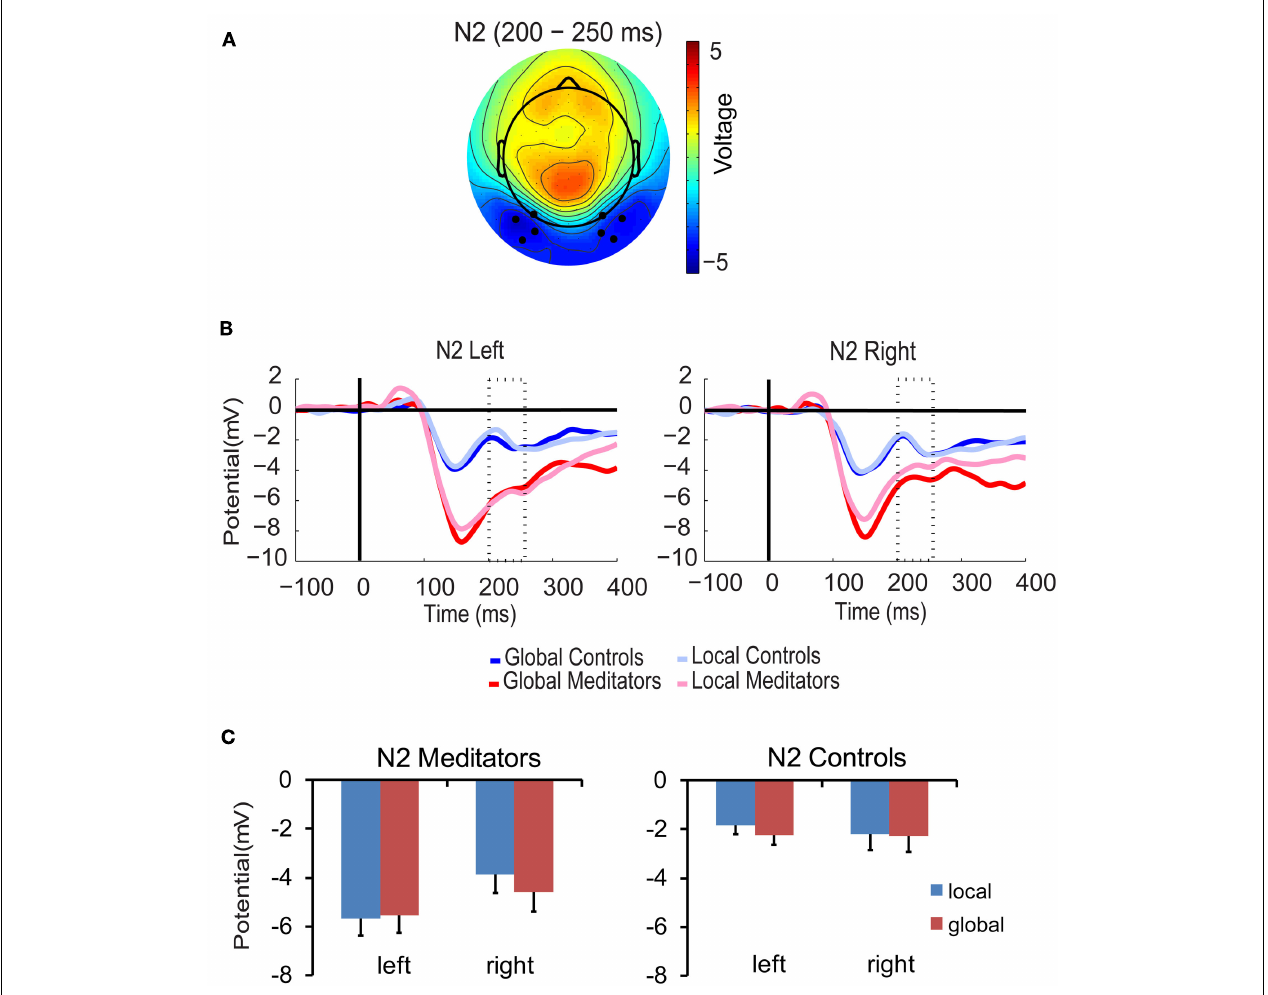
FIGURE 5 | N2 component. (A) Scalp topographies of the N2 component over conditions, groups, and the N2 time period (200–250ms). Black dots represent the electrodes included in the analysis. (B) N2 waveforms. (C) Bar plots. All conventions as in Figure 3